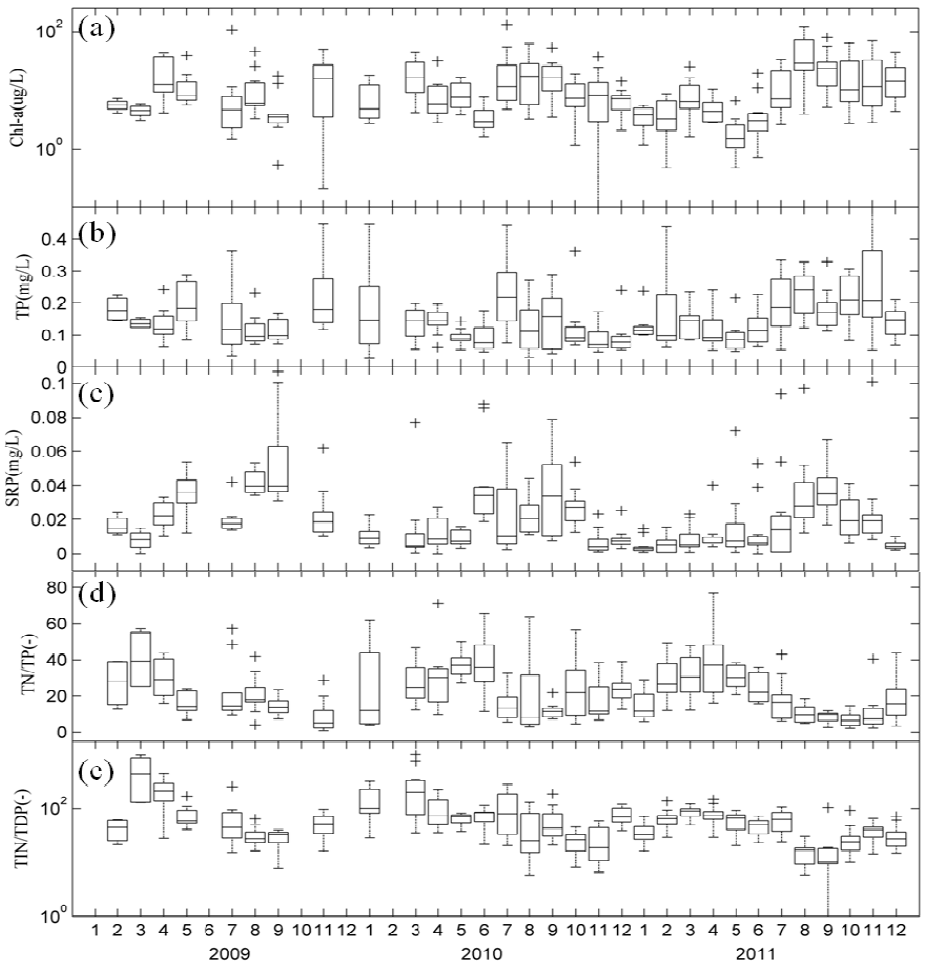
Figure 3. Monthly variability of Chl-a, TP, SRP, TN/TP and TIN/TDP in Lake Taihu: ( a ) Chl-a; ( b ) TP; ( c ) SRP; ( d ) TN/TP; and ( e ) TIN/TDP boxplot for nine sampling sites. The crosses “+” represent